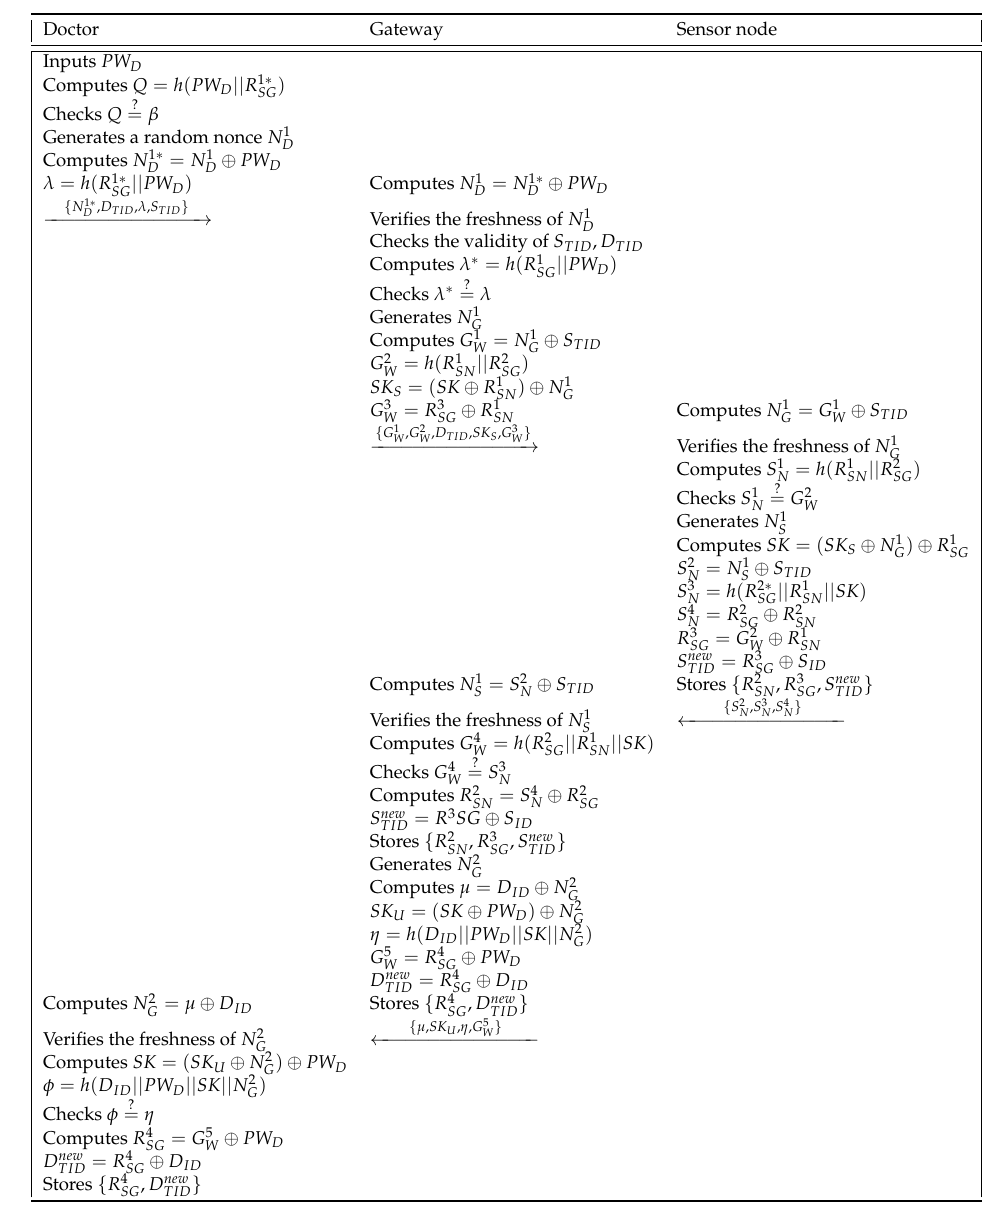
Figure 2. Mutual authentication and key agreement phase of Masud et al.’s